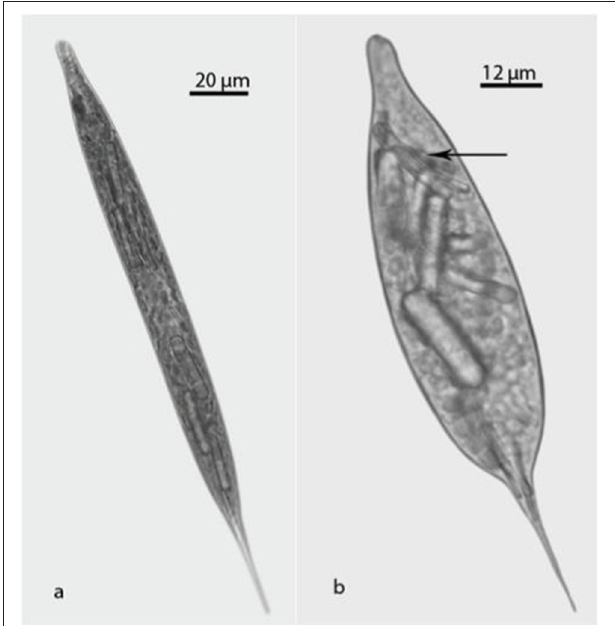
FIGURE 1 | Light microscopic photographs of Lepocinclis acus : (a) Normal cell; (b) Treated cell. Fan-like paramylon (arrow).